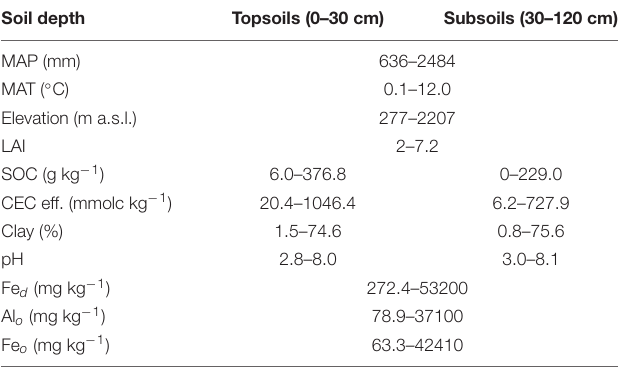
TABLE 1 | Ranges of climatic, vegetation and edaphic, variables.